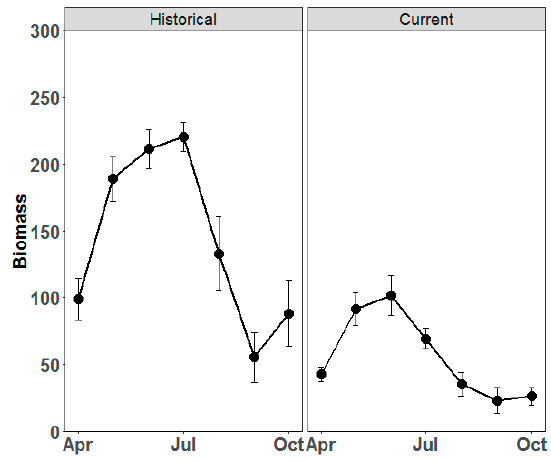
Figure 2. Z. marina mean (±SE) monthly aboveground biomass (g DW m − 2 ) comparisons between historic (left; 1980s–1990s) and current field surveys (right; 2004–2017). Historical data are adapted from Moore et al. 2000 [17].